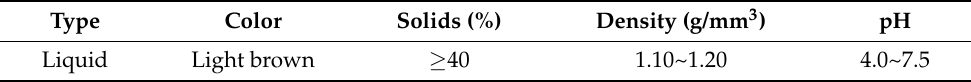
Table 6. Properties of the polycarboxylic acid-based, high-performance water-reducing agent.